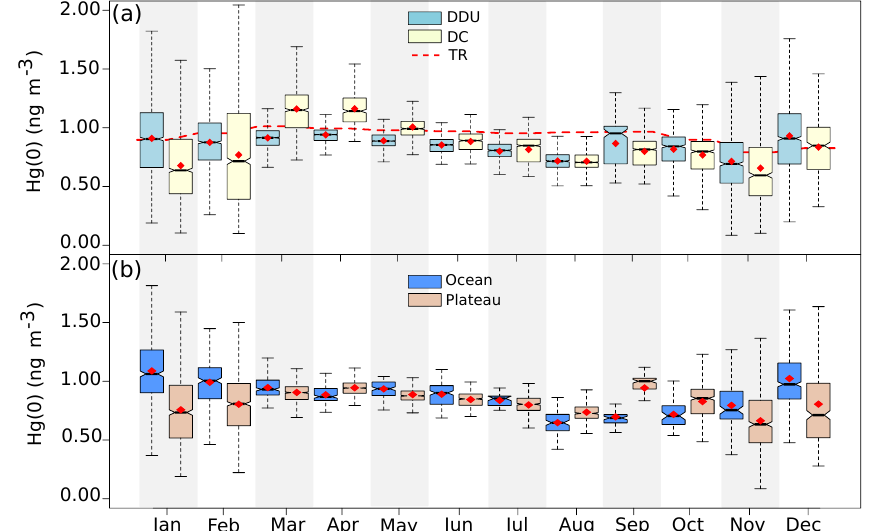
Figure 3. Box and whisker plot presenting the monthly Hg(0) concentration distribution (a) from all the data collected at DDU and DC along with the monthly mean recorded at TR, and (b) from all the data collected at DDU associated with air masses originating from the ocean or the Antarctic plateau according to the HYSPLIT simulations. Red diamond: mean, bottom and top of the box: first and third quartiles, band inside the box: median, ends of the whiskers: lowest (highest) datum still within the 1.5 interquartile range of the lowest (upper) quartile. Outliers are not represented.